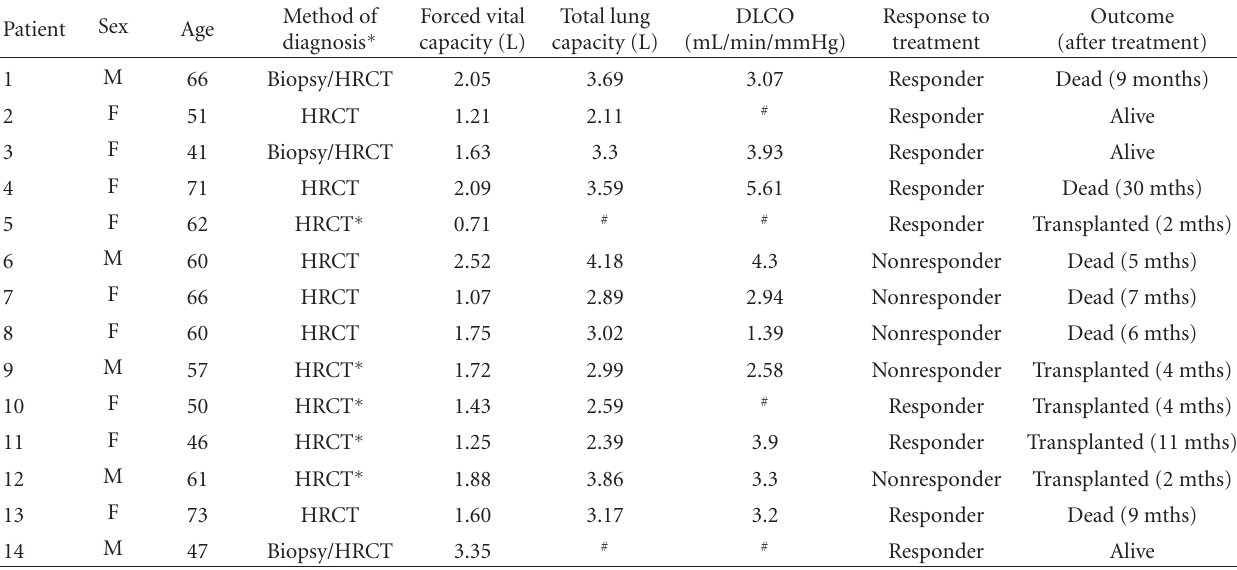
Table 1: Patient demographics.